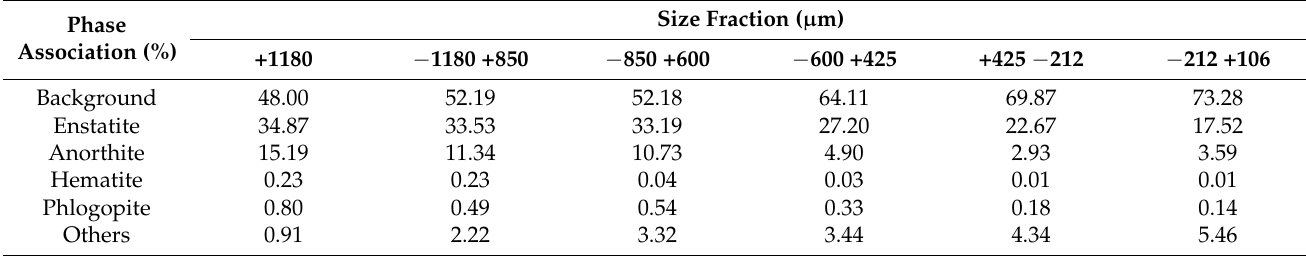
Table 7. Spinel association with other mineral phases (data from QEMSCAN